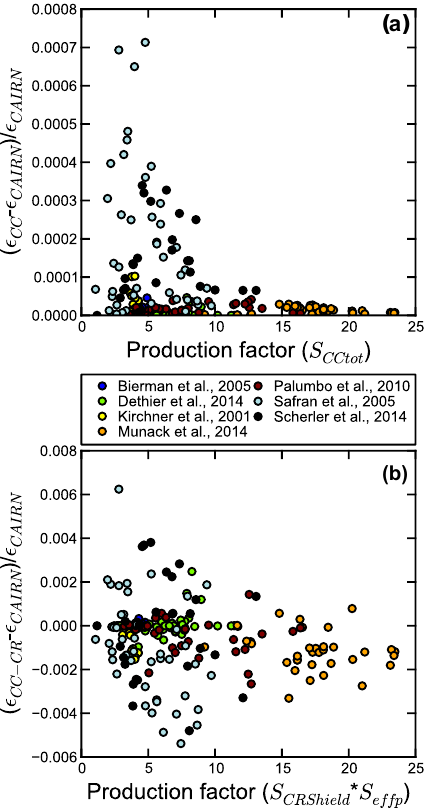
Figure 2. Differences between the denudation rate calculated by CAIRN ( (cid:15) CAIRN ) and the denudation rate using the production factor ( S CCtot ) (which includes production scaling and shielding) passed to COSMOCALC ( (cid:15) CC ) (a) , and differences between the denudation rate calculated by CAIRN ( (cid:15) CAIRN ) and the denuda- tion rate using separate spatial averages for shielding and produc- tion scaling that are then averaged ( (cid:15) CC-CRONUS ) as a function of production factor (b) . In this case the production factor is calcu- lated by multiplying the separately averaged shielding ( S CRShield ) and scaling ( S effp ) factors. This approach emulates the data require- ments for CRONUS-2.2, which calculates production scaling and accepts a single shielding factor (for snow and topography com- bined). Although the shielding and scaling emulate data require- ments for CRONUS-2.2, the denudation rate is calculated using the exponential production method of CAIRN and COSMOCALC.